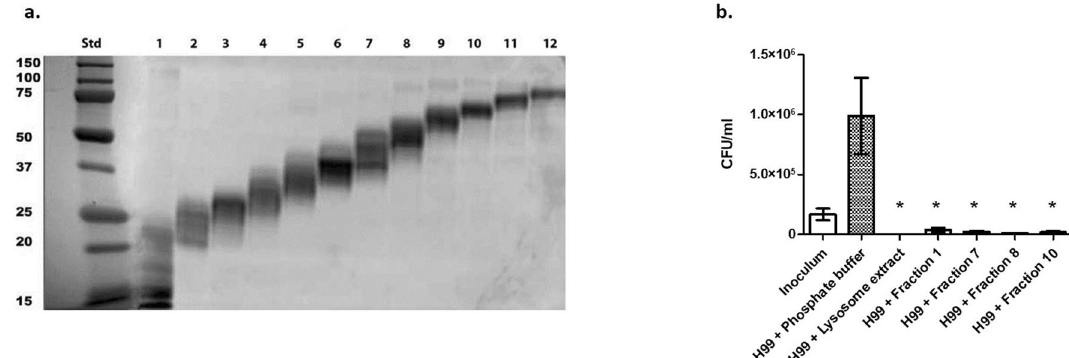
Figure 1. Fractions of DC Lysosomal Extract Have Anti-cryptococcal Activity. ( a ) Crude DC-derived lysosomal extracts were separated by molecular weight using a GELFrEE 8100 system into 12 different fractions and further resolved by standard SDS-PAGE. Proteins in the 12.5% gels were stained using BioSafe Coomassie Stain and visualized using a Gel Doc XR + system. ( b ) C. neoformans serotype A strain H99 yeast cells (1 × 10 5 cells/ml) were incubated in phosphate buffer (pH 5.5) with whole lysosomal extract or fractions of lysosomal extract for 24 h at 37 °C, 5% CO 2 , following which CFUs in the wells were determined. Data shown are means ± standard errors of the means (SEM) of the results of three independent experiments (n = 3), with each condition performed in duplicate. Two-tailed t-tests comparing H99 inoculum to each treatment were performed with asterisks (*) indicating significantly lower CFUs of treatment compared to the H99 inoculum (fraction 8: p = 0.0001, all others: p <